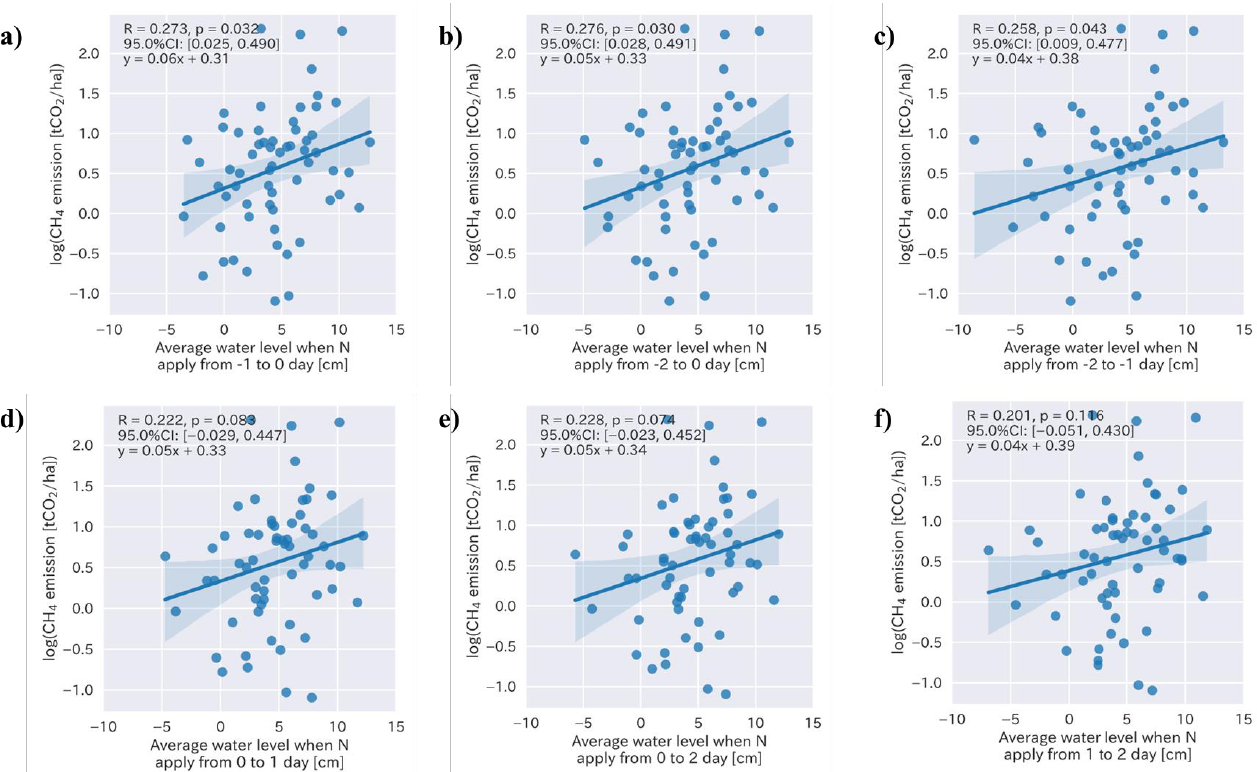
Figure 6. Relationship between methane emissions and average water levels two days before and after nitrogen fertilizer application.